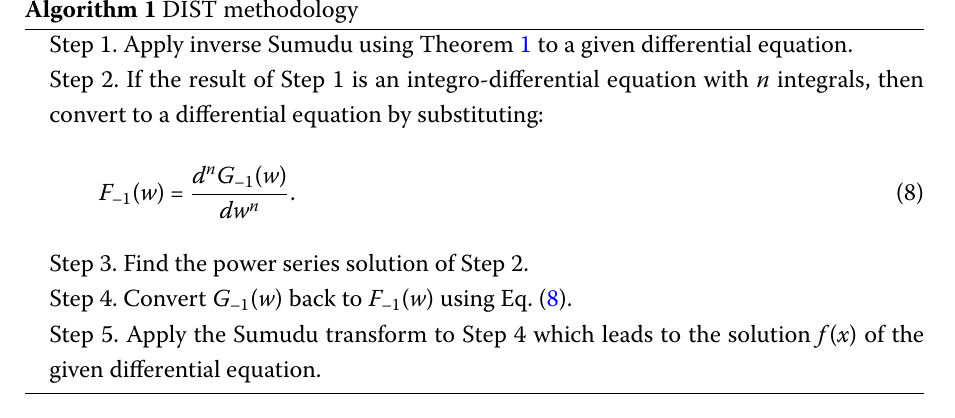
Algorithm 1 DIST